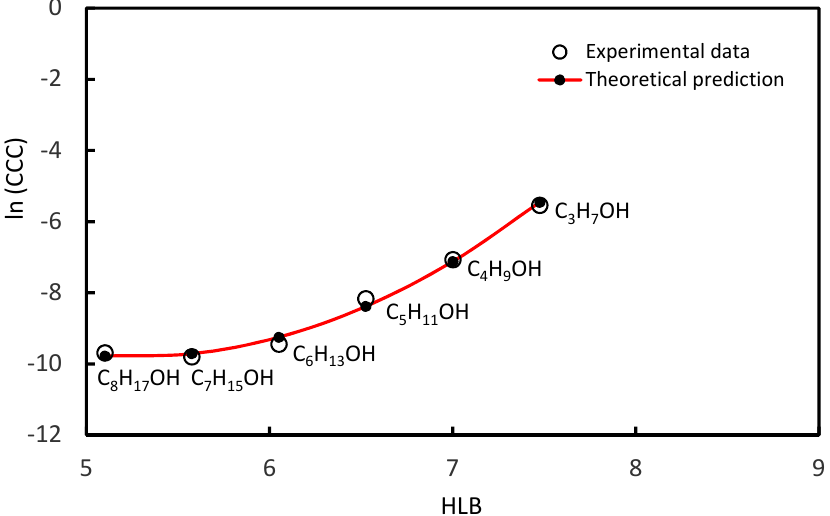
Figure 2. Experimental [37] and theoretical (see Equation (2)) values of ln(CCC) versus HLB values of homologue series of primary alcohols C 3 H 7 OH–C 8 H 17 OH.